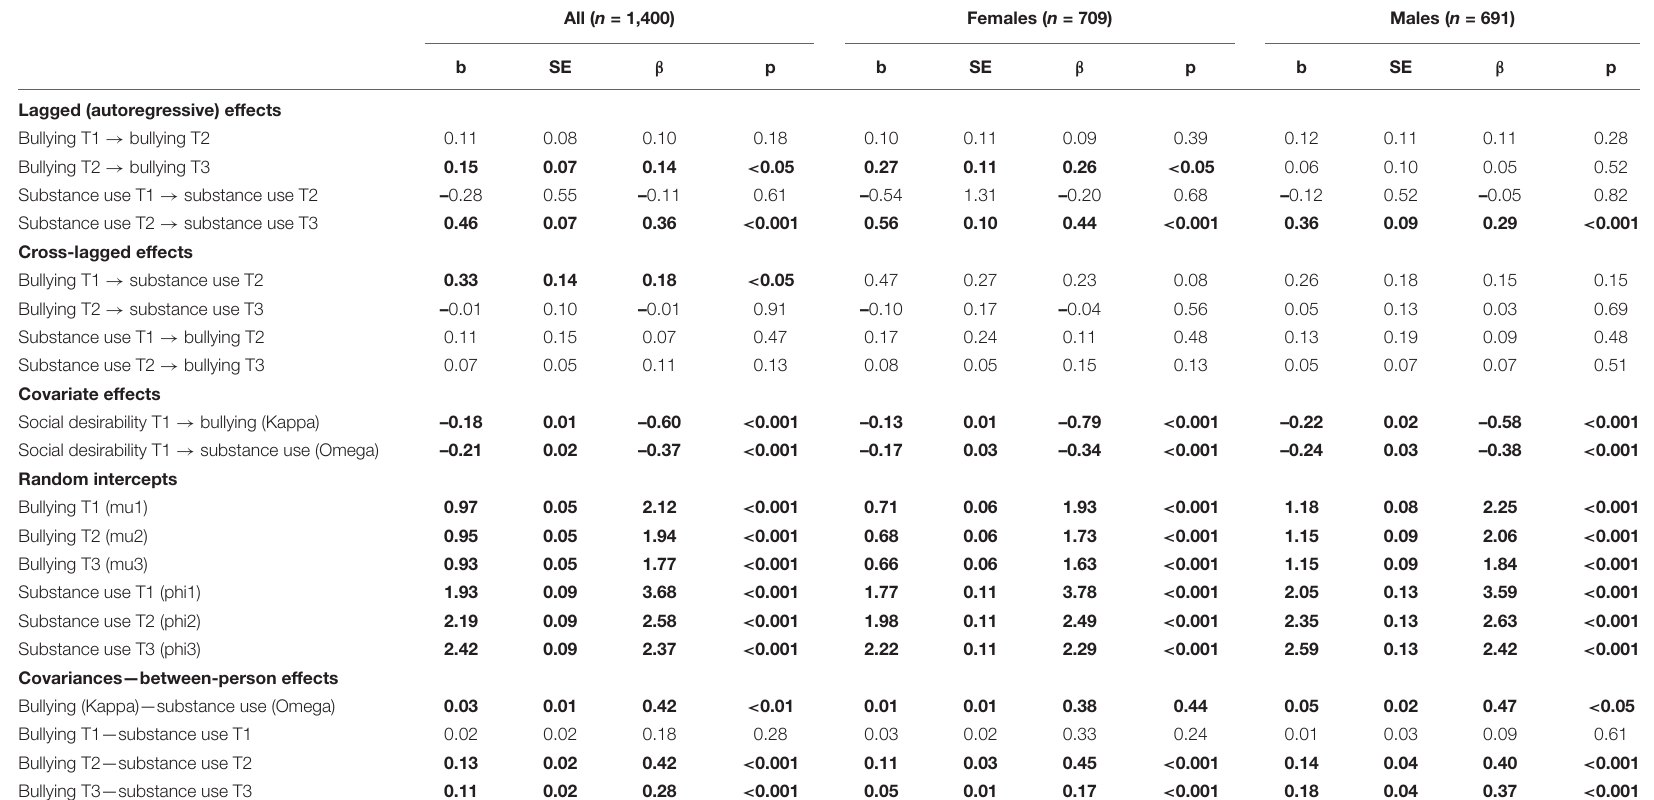
TABLE 5 | Summary of the parameters for the whole sample and by gender of the unconstrained RI-CLPM (Model